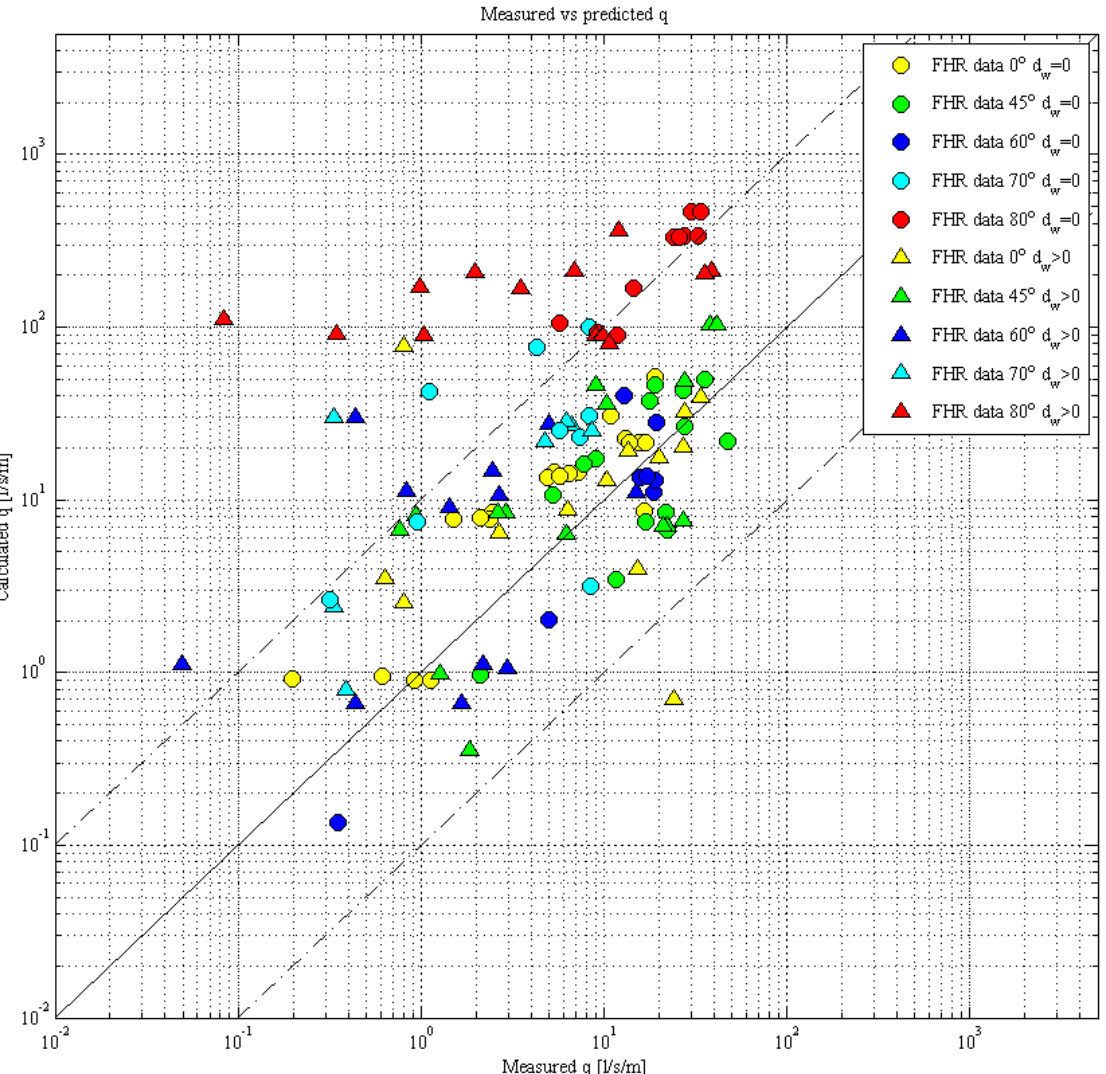
Figure 9. Quay wall: predicted [1] vs. measured overtopping discharges. The circles indicate the cases without berm crest (d w = 0), the triangles indicate the cases where a berm crest is present (d w > 0).